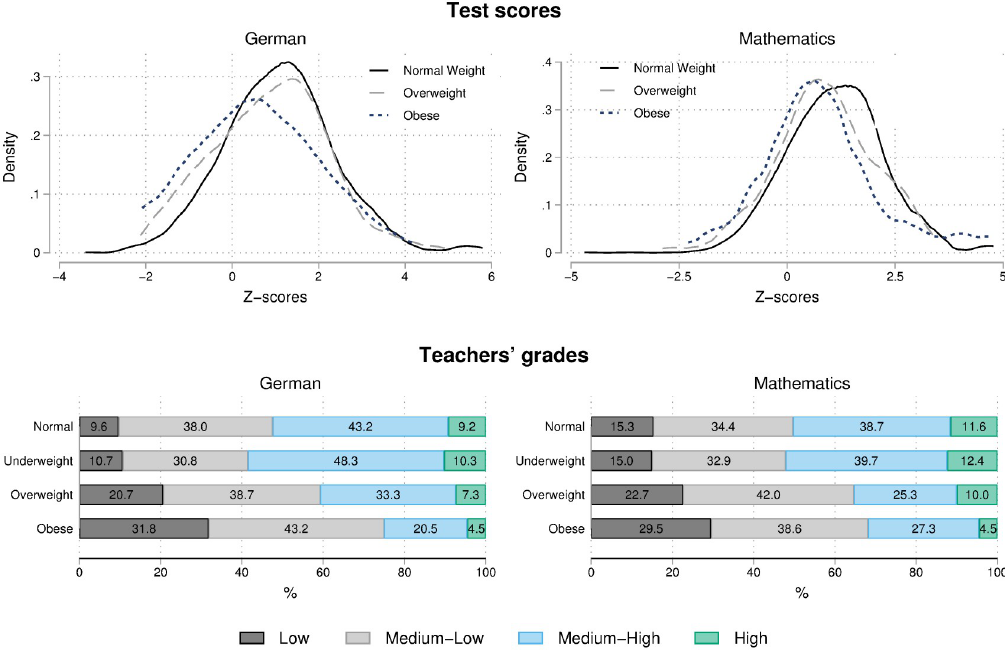
Fig 1. Distribution of test scores and teachers’ grades by students’ weight category. The upper-left graph shows Kernel density estimates of the distribution of test scores in German, the upper-right graph in mathematics. The lower-left graph shows the distribution of teachers’ grades by students’ weight category in German, and the lower-right graph in mathematics.